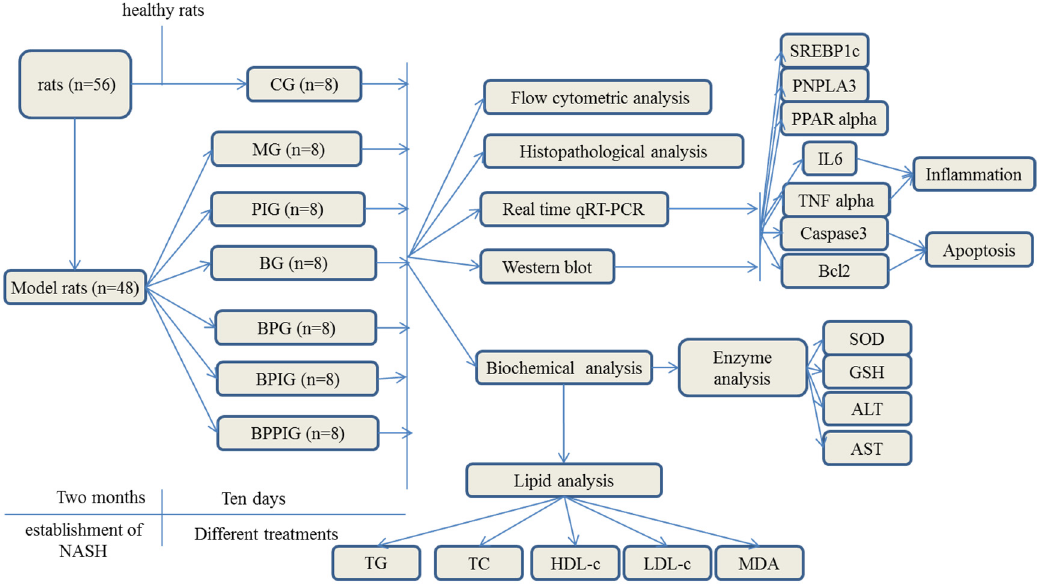
Figure 1. The flow chart of the study.